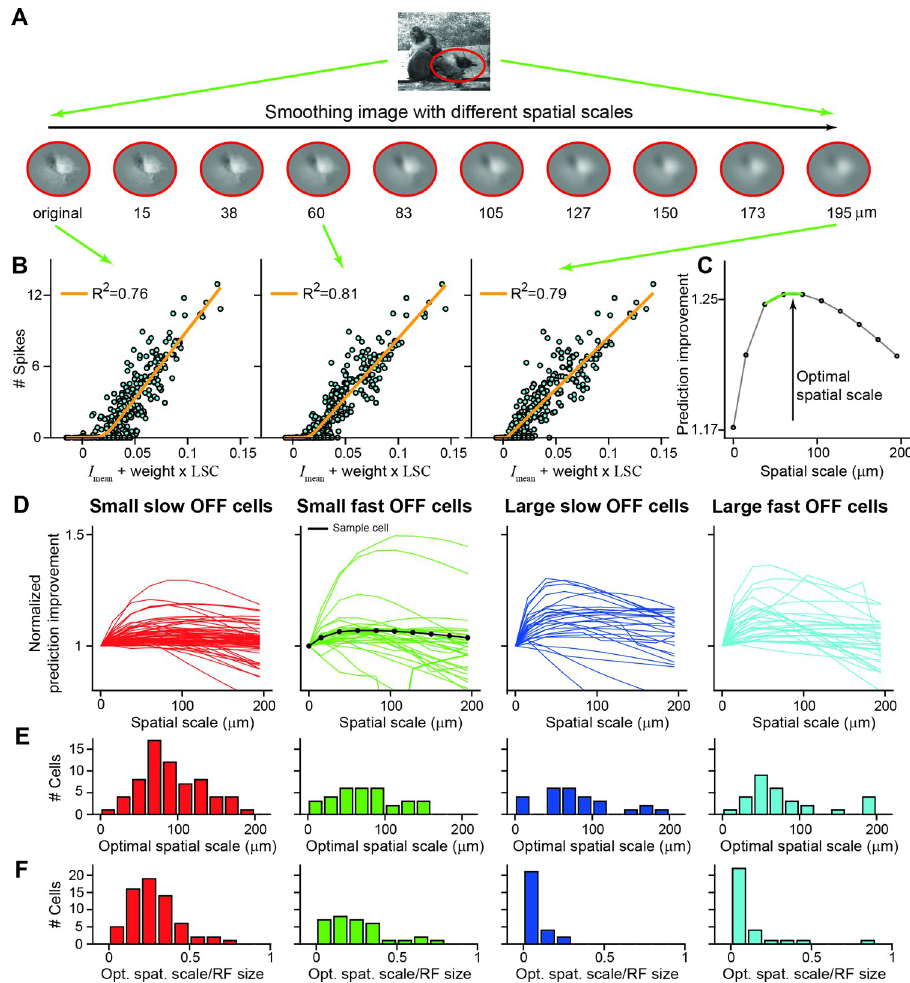
Fig 6. Analysis of the optimal spatial scale for calculating the local spatial contrast. A) Sample image overlaid with the 3-sigma outline of a sample cell’s receptive field (red curve). Below: Local stimuli after smoothing with a 2D Gaussian filter with increasing spatial scale from 15 to 195 μ m and pixel-wise weighting by the sample cell’s spatial receptive field. The first image is without smoothing. B) Relation between linear signal of the SC model and measured spike count, using the same I mean values, but LSC values derived from the differently smoothed images, displayed here for the original image and for the images with spatial scales of smoothing of 60 and 195 μ m, respectively. The orange lines show the fitted nonlinearities, and the R 2 values denote the corresponding model performance. C) Prediction improvement as a function of the level of smoothing for the sample cell. The optimal spatial scale is defined as the spatial scale at which R 2 reaches its maximum (as determined by the 2 nd -order polynomial fit around the maximal data point; green line). D) Prediction improvement, normalized by the prediction improvement with no image smoothing, as a function of the level of smoothing for all cells, shown separately for the four cell classes of Fig 4. The data from the sample cell is shown in black. E) Distributions of optimal spatial scales. F) Distributions of optimal scales, normalized by each cell’s receptive field